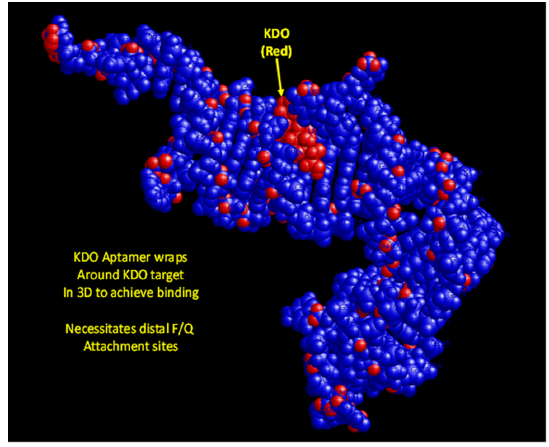
Figure 4. A space-filing 3D aptamer model visualized with RasMol software showing extremely tight binding to the core KDO antigen of LPS.